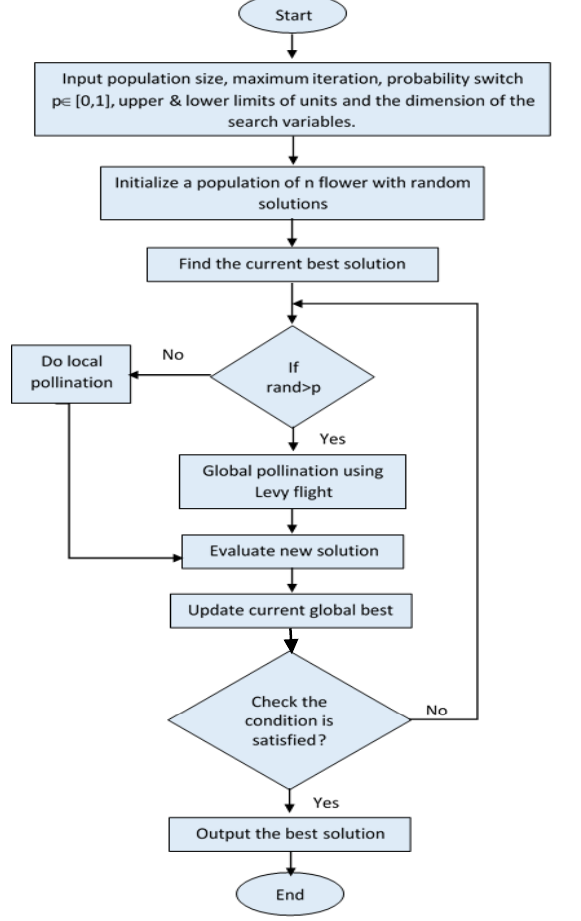
Fig.4: The flowchart of the FPA technique.